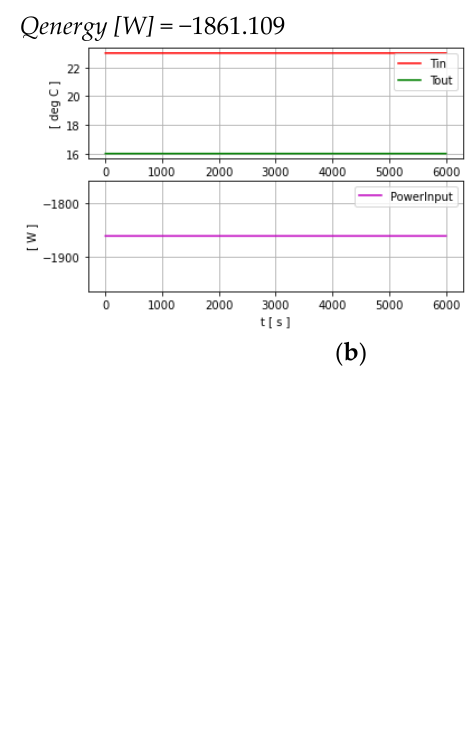
Figure 7. ( a – c ) Simulated results.